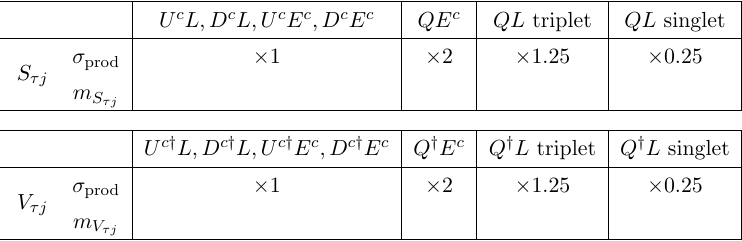
Table 9 . MLQ models which decay into the (cid:12)nal state ( (cid:28)j )( (cid:28)j ). We have not been able to (cid:12)nd searches which can reliably and easily be recast to obtain mass limits for these models.